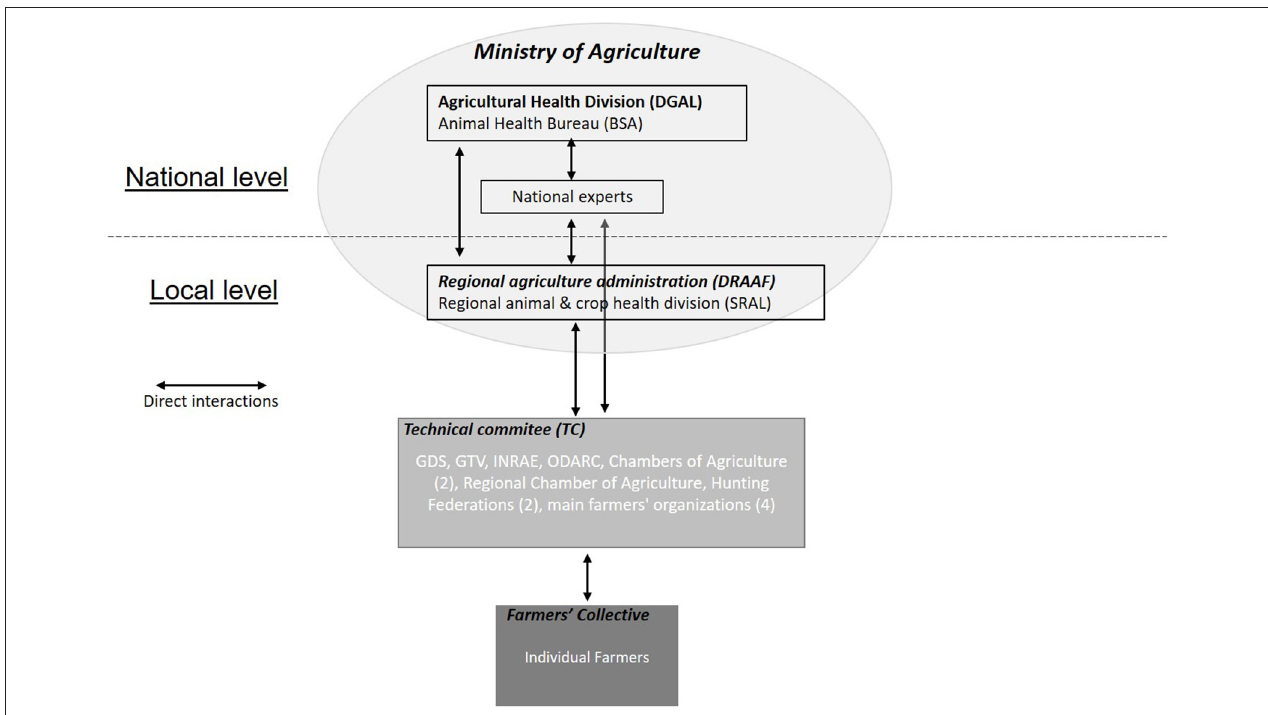
FIGURE 1 | Interactions between the different actors in the territorial preparedness process against African swine fever (ASF) in Corsica (2019–2021).